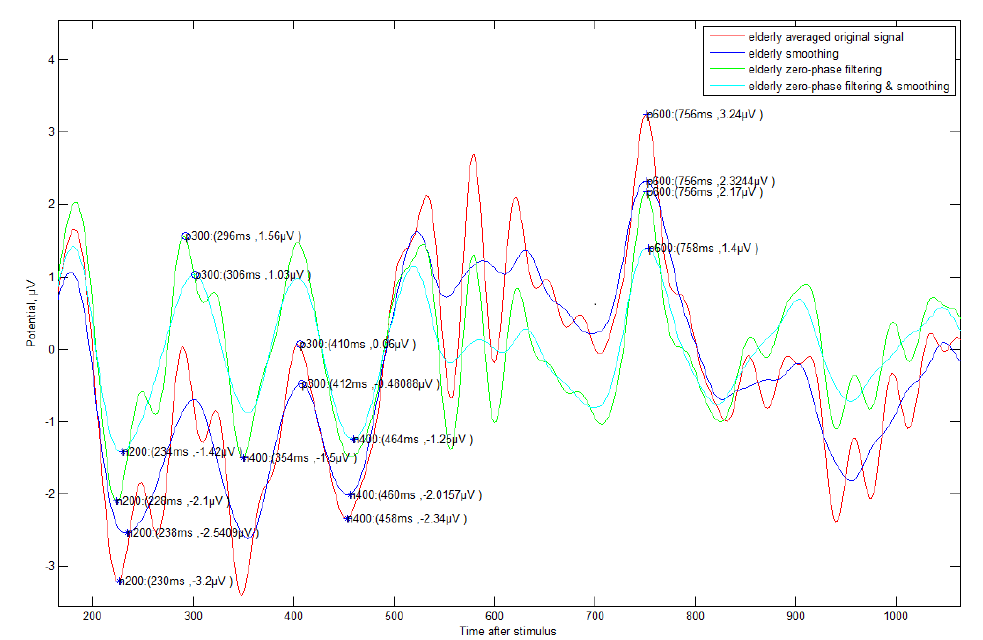
Figure 7. ERP Case Study 1—Elderly subjects (#9)’s correct answer about triangle symbol: There is a change in the time of detection of P300 ERP components according to various methods of signal processing.